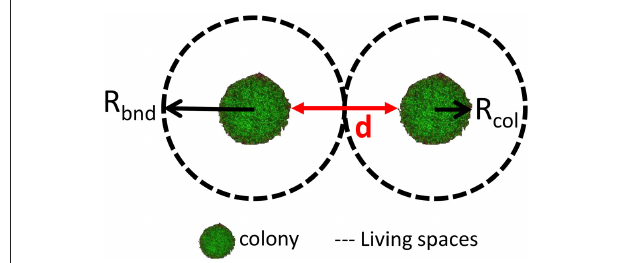
FIGURE 1 | Representation of the colony and its surrounding “living space” (the area within which the colony is active) with the two respective radii R col and R bnd ; d is the distance between two neighboring colonies. Adapted from Malakar et al. (2002a) and Wimpenny